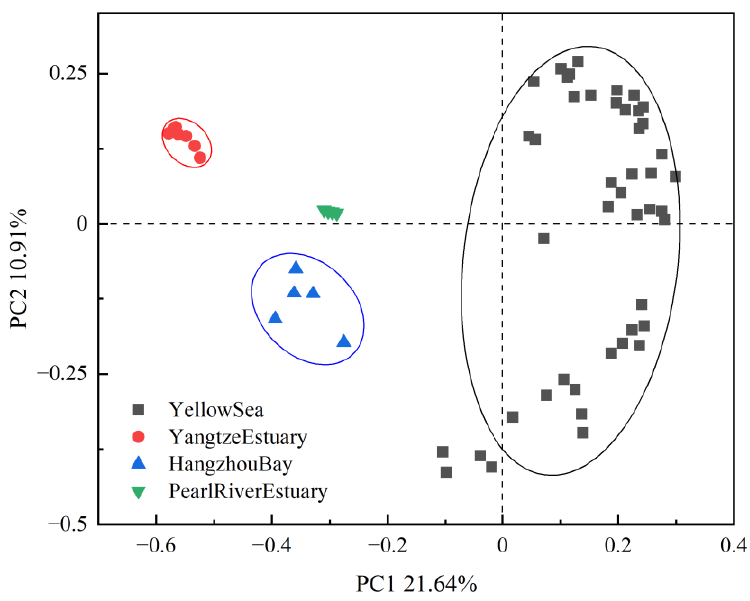
Figure 9. Principal component analysis plot of bacterial communities in Hangzhou Bay, Pearl River Estuary, Yangtze Estuary, and Yellow Sea.